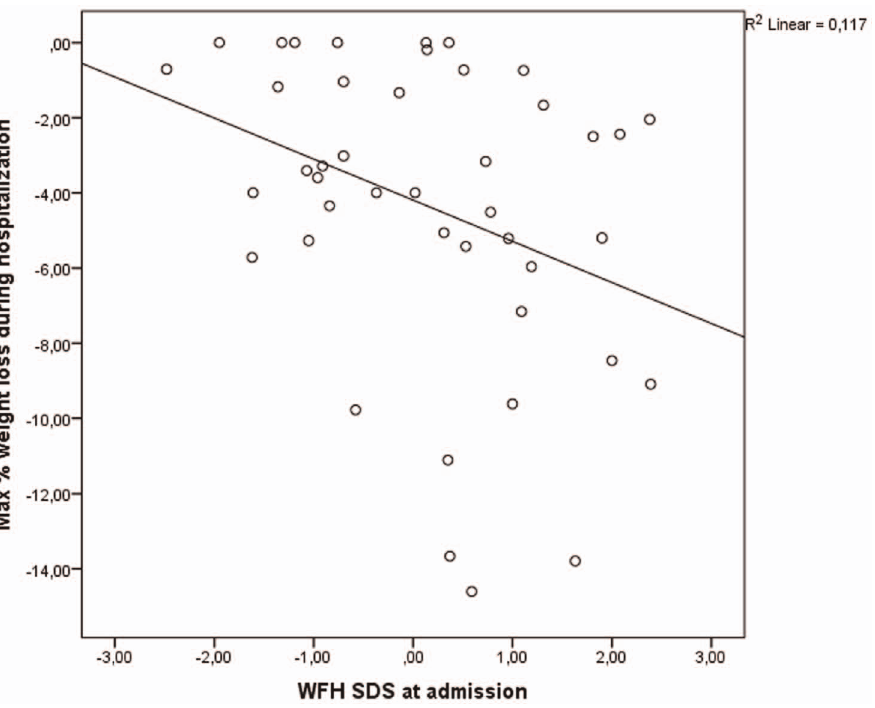
Figure 1. Correlation between max % weight loss during hospitalization and WFH z-score at admission. WFH: weight for height .